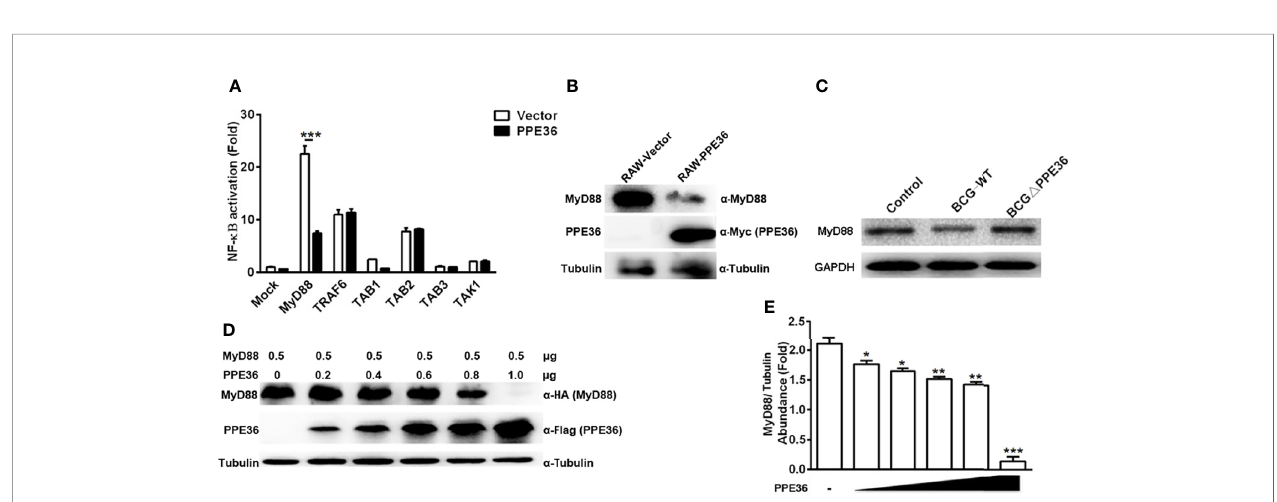
FIGURE 5 | PPE36 facilitated host MyD88 protein degradation. (A) Luciferase assay of NF- k B activation in HEK293T cells co-transfected with pPPE36 and plasmids encoding various signaling molecules (TAK1, TAB1, TAB2, TAB3, TRAF6, and MyD88) respectively. (B) MyD88 expression in PPE36-stably expressing RAW264.7 cells (RAW-PPE36). (C) MyD88 expression in the WT BCG- or BCG D PPE36-infected macrophages. (D, E) MyD88 expression in the HEK293T cell line transfected with different doses of pPPE36-Flag. *p < 0.05, **p < 0.01, ***p <0.001.